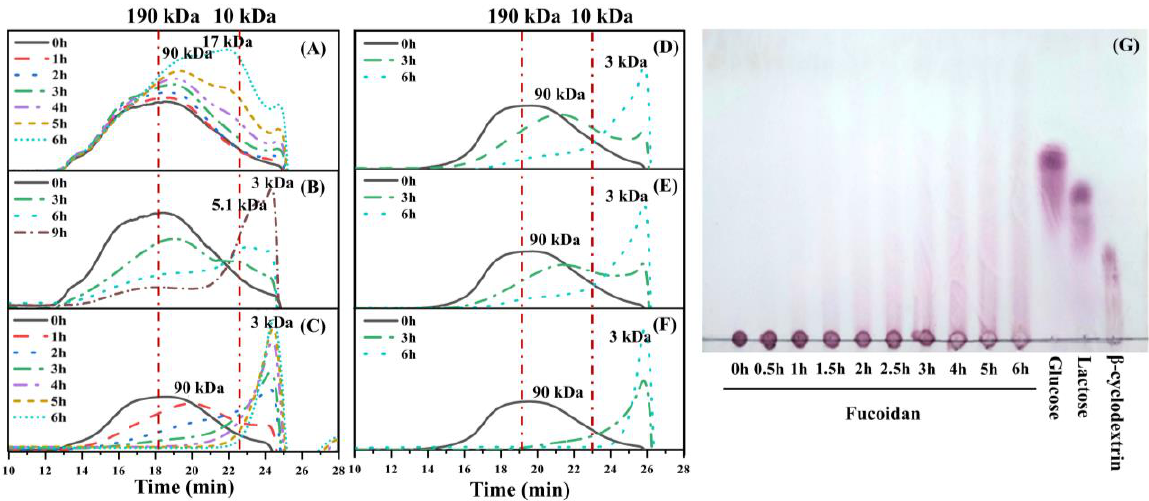
Figure 1. Molecular weight distribution of fucoidan degraded with 1% TiO 2 ( A ), 5% TiO 2 ( B ), 5% TiO 2 and 0.95% H 2 O 2 ( C ), 5% TiO 2 and 0.24% H 2 O 2 ( D ), 5% TiO 2 and 0.48% H 2 O 2 ( E ), 5% TiO 2 and 0.95% H 2 O 2 ( F ), and TLC of degraded fucoidan ( G ).